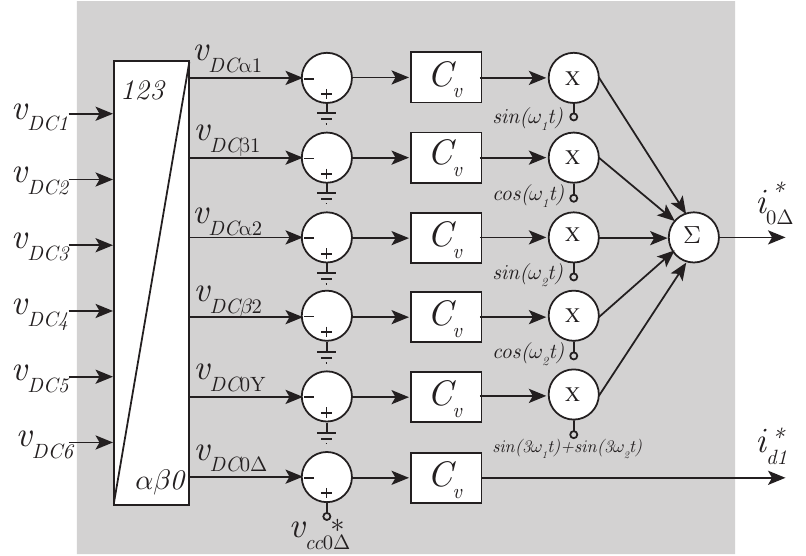
Figure 5. Voltage control scheme for the